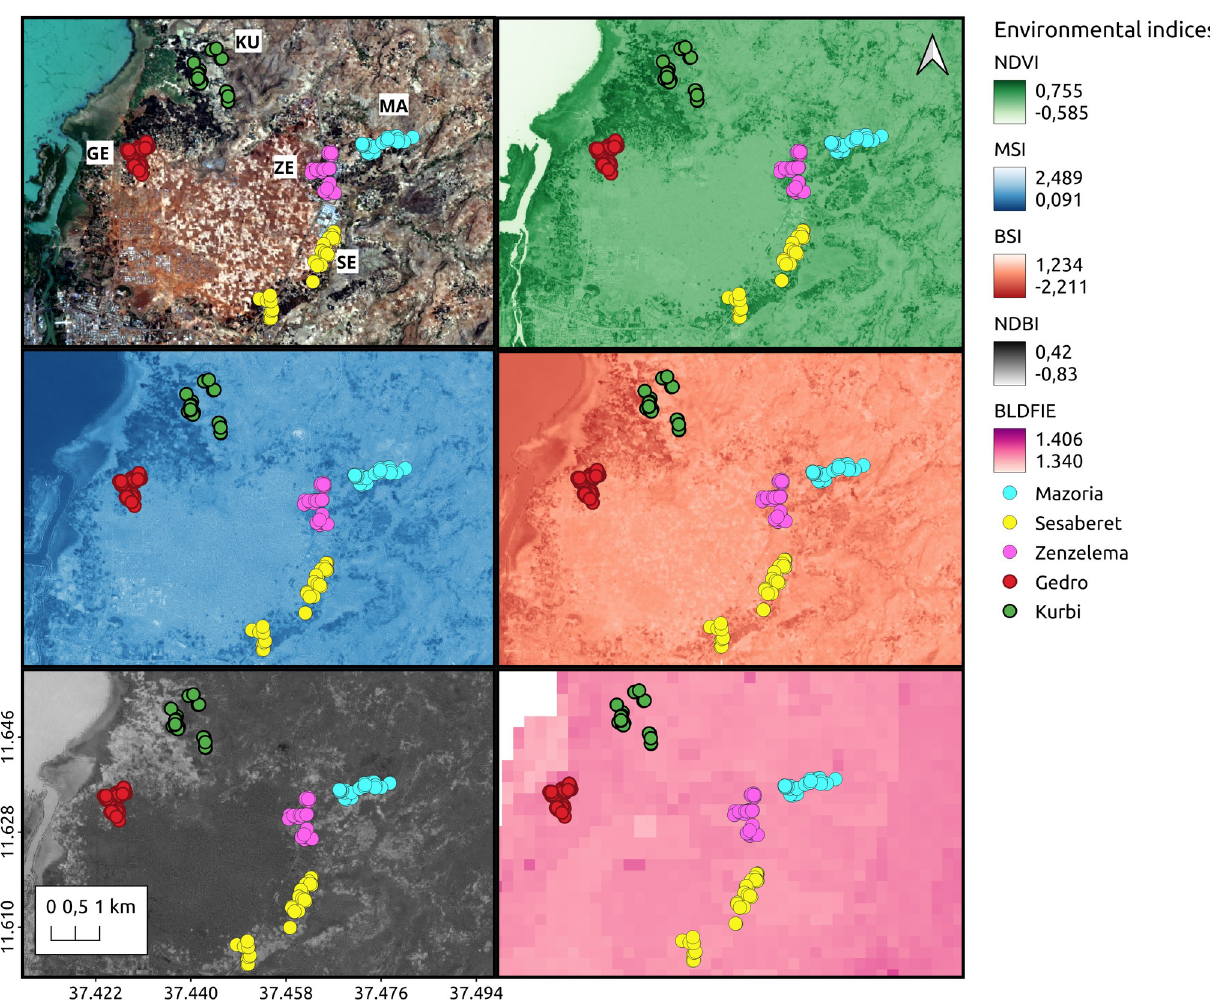
Fig 6. Spatial distribution of the different soil and environmental indexes analyzed. NDVI: Normalized Difference Vegetation Index. MSI: Moisture Stress Index. BSI: Bare Soil Index. NDBI: Normalized Difference Built-up Index. BLDFIE: Soil Bulk density. Landsat-8 images, "Image courtesy of the U.S. Geological Survey", downloaded from the US Geological Survey server (USGS, https://www.usgs.gov) using Earth Explorer platform (https:// earthexplorer.usgs.gov). The geographical location for Landsat-8 is: Path 170, Row 52. DATE_ACQUIRED = 2016-03-10.